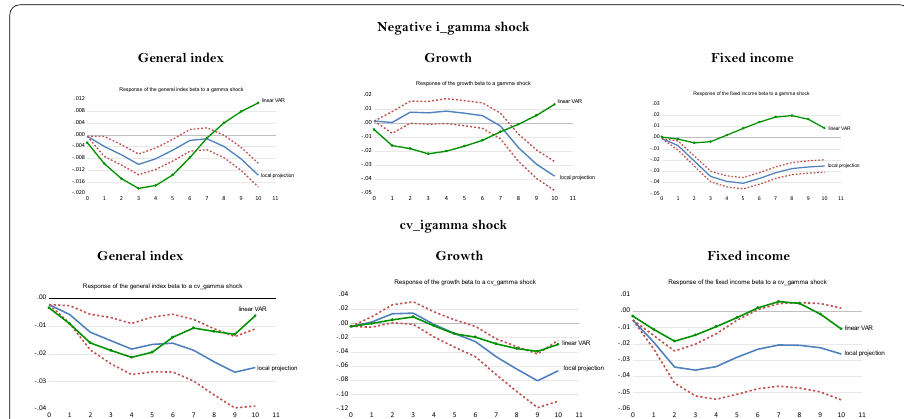
Fig. 6 Local projection of illiquidity shocks on the beta of the general index, growth and fixed income strategies over the subprime crisis with cv_igamma not instrumented. Notes: Liquidity shocks are measured by the main series of Pástor and Stambaugh (2003)—i.e., the innovation in aggregate liquidity ( i_gamma )— and its conditional variance as computed by the EGARCH (Nelson 1991) method ( cv_igamma ). The impulse response functions corresponding to the linear LP are built using the Jordà’s (2004, 2005, 2009) algorithm provided by Eren Ocakverdi, consultant at Yapy Kredi. The local projection of a beta strategy is performed over the subprime crisis (2007Q3–2009Q4). We also provide the linear VAR estimated over the whole sample period selected as benchmark. The confidence interval of the LP impulses, computed at the threshold of 95%, is in dotted lines. As explained in the paper, our model comprises six endogenous shocks, placed in the following order to perform the Cholesky factorization (Sims 1980) required to build structural shocks: GDP growth, term spread, credit spread, beta (own shock), i_gamma , and cv_igamma . As usual, these variables are ordered by increasing level of endogeneity. This order relies on the conventional information criteria: Akaike and Schwartz